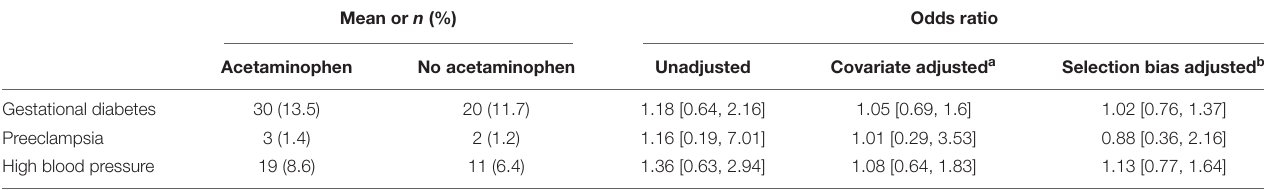
TABLE 3 | Associations of meconium acetaminophen with pregnancy complications ( N = 393). Mean or n